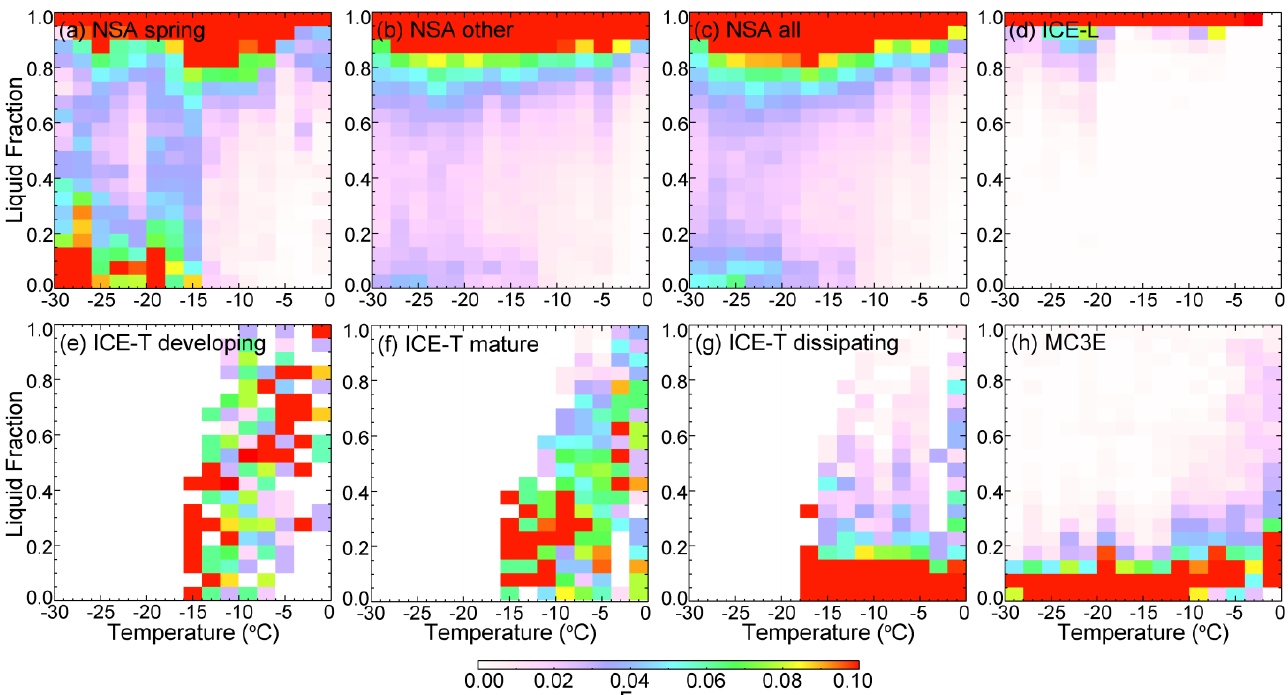
Figure 8. Frequencies of the liquid fractions in mixed-phase clouds sampled over NSA using ground-based remote sensors, and the frequencies during ICE-L, ICE-L and MC3E using aircraft in situ